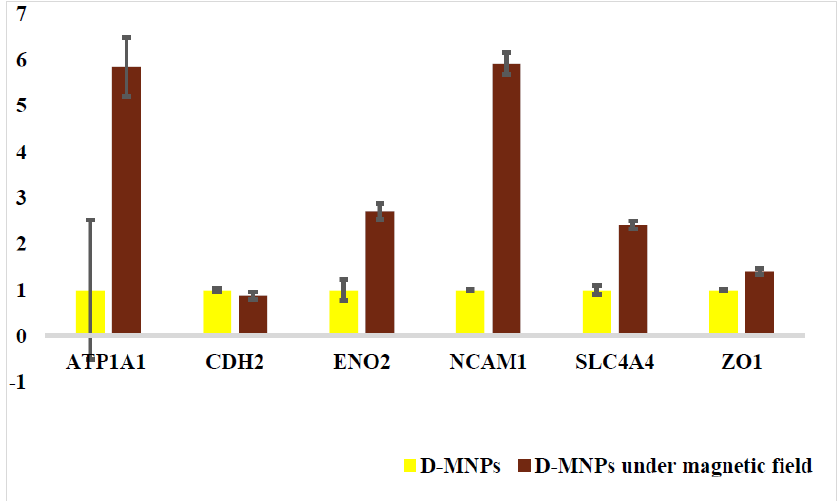
Figure 8. Gene expression level of BCECs incubated with D-SPIONs and treated with an electromagnet system using real time PCR. The genes were normalized using GAPDH. The cells incubated with the MNPs were used as the control group and statistically differences were ( p < 0.05; n = 3). Data are presented as the means standard deviations of three experiments.